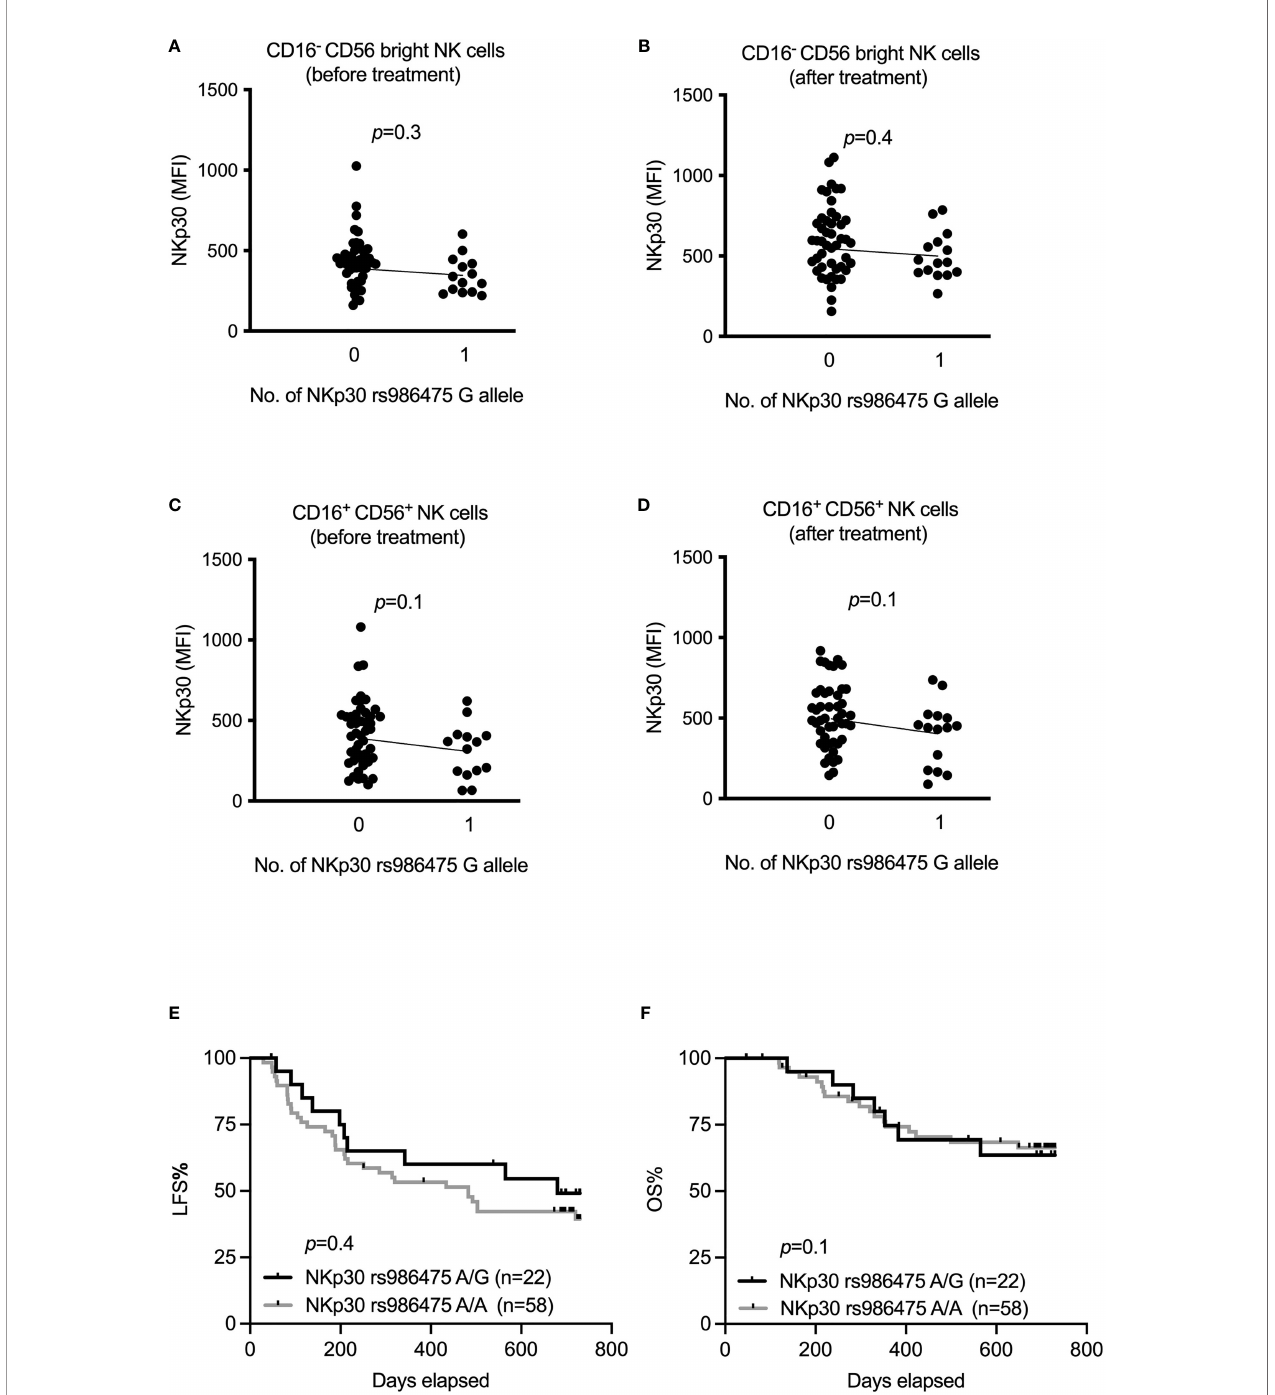
FIGURE 3 | Impact of NKp30 rs986475 gene polymorphism on expression of NKp30 and clinical outcome of AML during immunotherapy. (A – D) Median fl uorescence intensity of NKp30 based on genotype status of NKp30 rs986475 in AML patients in both CD16 - CD56 bright and CD16 + CD56 + NK cells before and after receiving one cycle of HDC/IL-2 therapy. Patients are divided according to presence (14 out of 61 before therapy, and 15 out of 62 after therapy) or absence of G allele in fi gures (A – D) . (E, F) Kaplan-Meier curves show impact of different NKp30 rs986475 genotypes on leukemia-free survival (LFS) and overall survival (OS) of AMLpatients after receiving HDC/IL-2 therapy. Simple linear regression was appliedto investigate impactof NKp30 gene variants onNKp30 expression both before and after immunotherapy invarious NKsubsets as shownin fi gures (A – D) . Logrank test was used to analyze the survival based on NKp30 gene variants in fi gures (E,F)